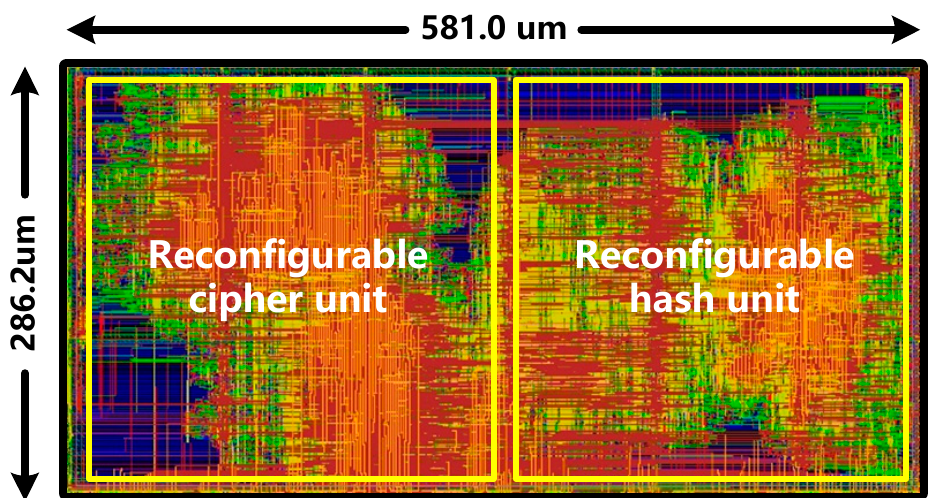
Figure 11. ASIC layout of the proposed reconfigurable cryptographic accelerator core in 65-nm CMOS process.